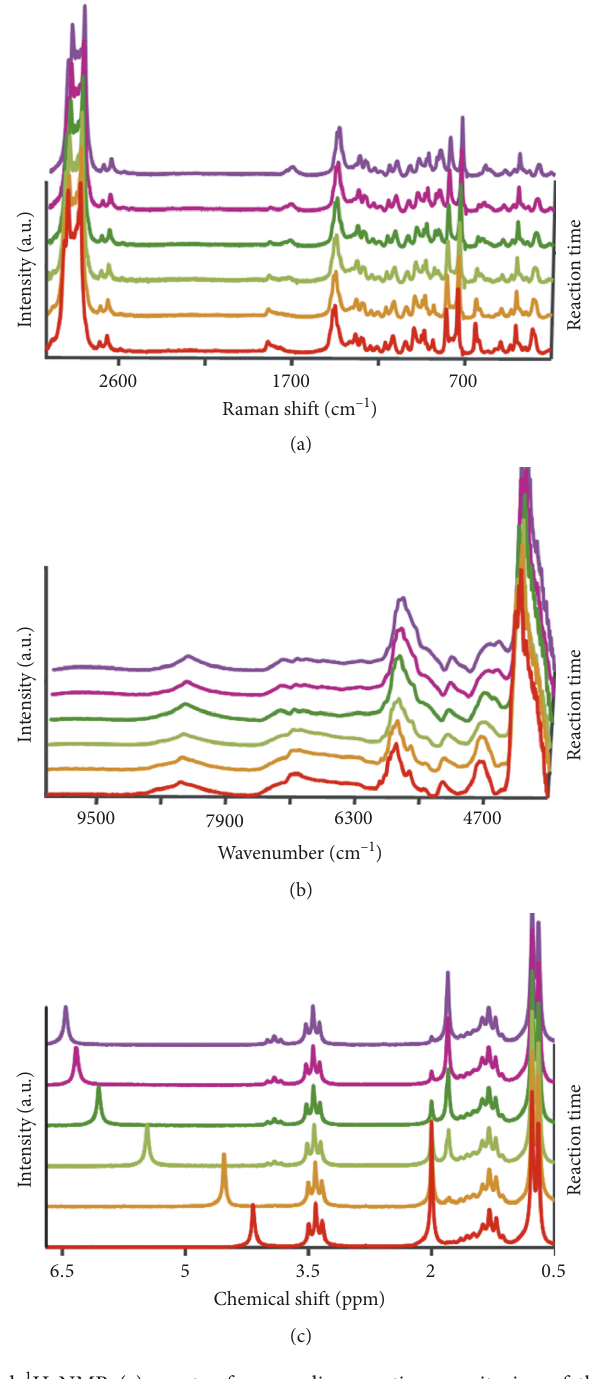
Figure 4: Raman (a), NIR (b), and 1 H NMR (c) spectra from on-line reaction monitoring of the enzyme catalysed reaction in the microreaction assembly. Spectra were recorded from the neat reaction mixture during 23 hours. NMR spectra, 16 accumulations, were acquired at 82 MHz and T � 36 ° C. NIR spectra were recorded using an immersion probe. Raman spectra, 64 accumulations, were acquired with laser excitation at 785nm. Color coding refers to corresponding reaction times among the spectroscopic methods. The reaction was followed over a period of acetic acid and acetic anhydride yielded comparable reaction rate constants from Raman and NMR spectroscopic moni- toring, showing the values of 2.1 and 2.2 · 10 − 3 min − 1 for the transformation from acetic anhydride to acetic acid (cf. Ta-